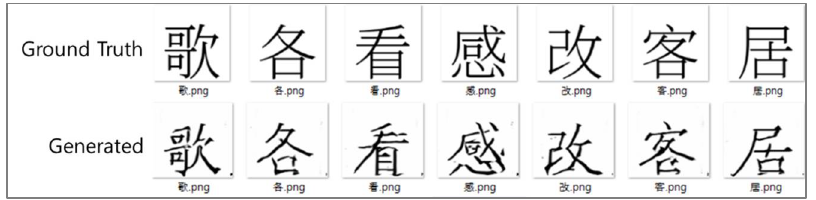
Figure 1. A sample case of failures to generate Chinese characters.